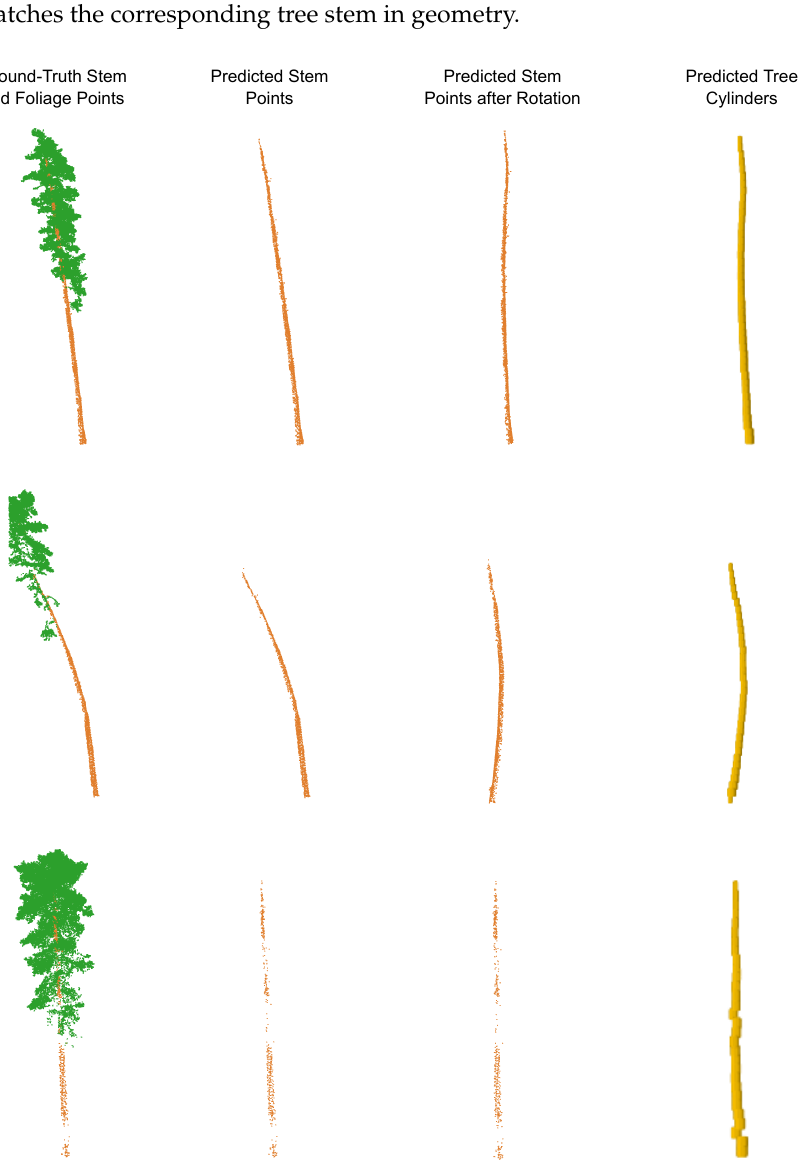
Figure 8. Visualisation of the parametric predictions of our DNN-based tree parameter estimation method compared with the predicted stem points. We use three different trees from our Tumut dataset as an example. Best viewed in